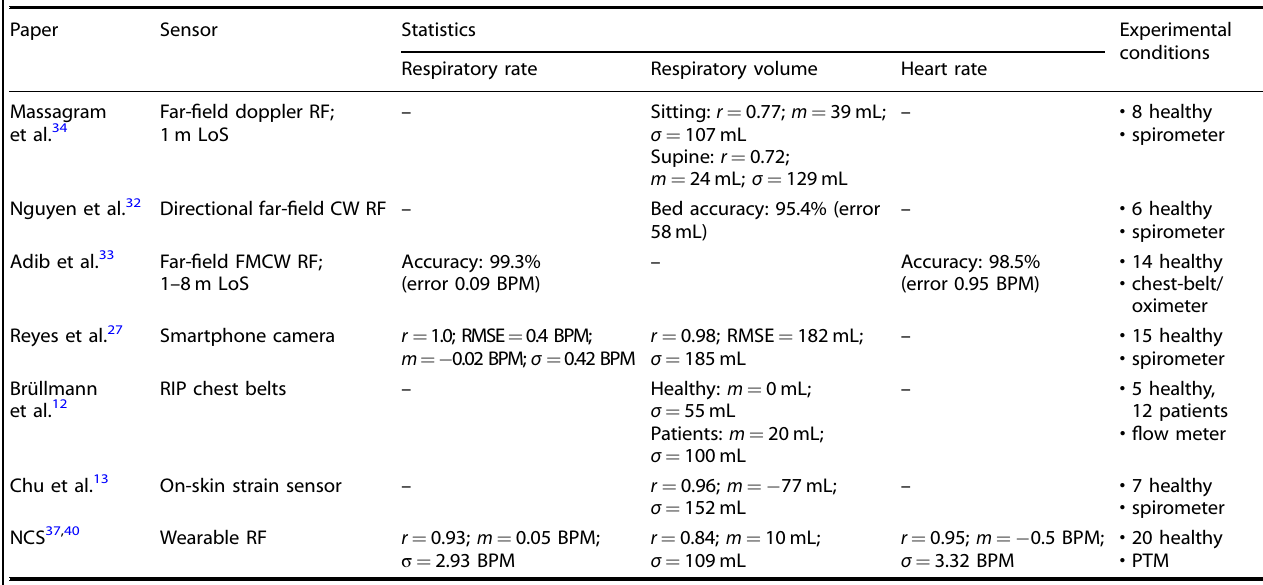
Table 3. Comparison with other noninvasive methods.